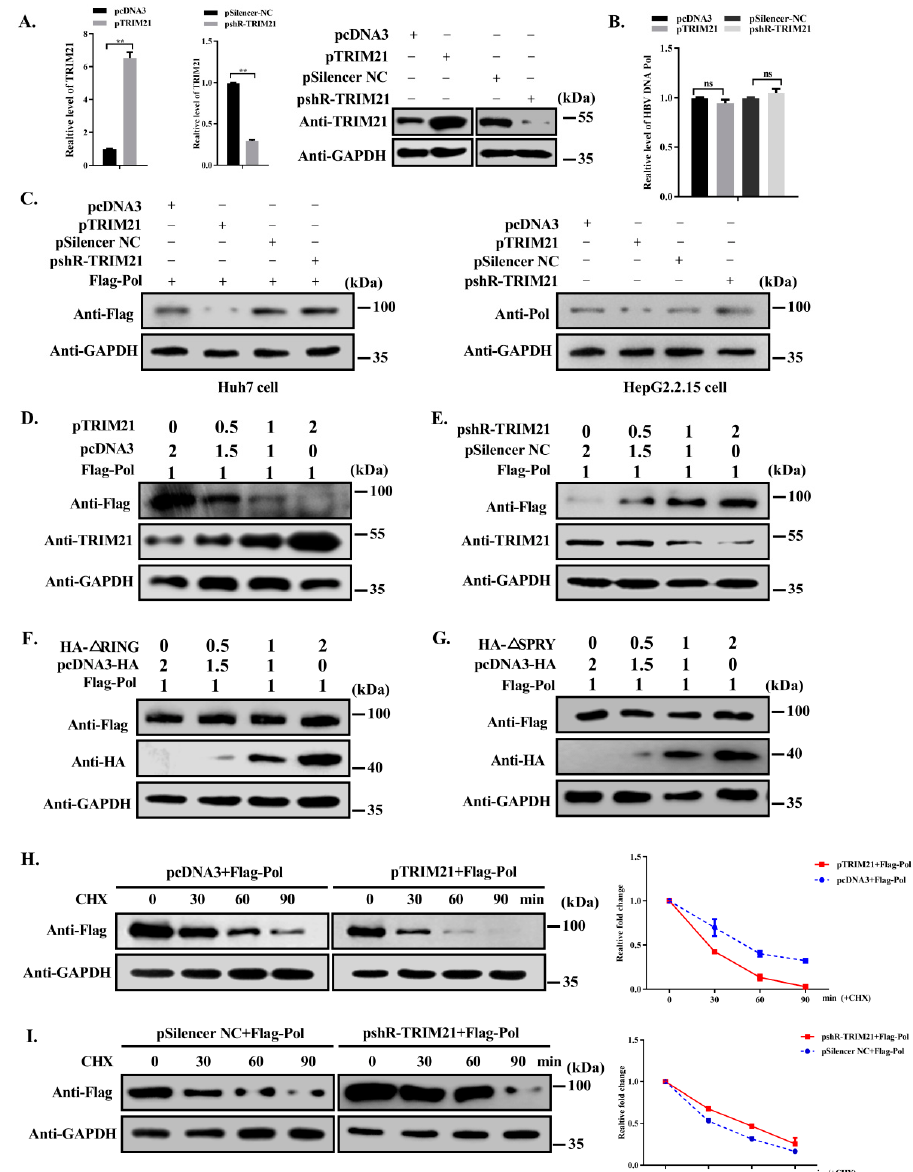
Figure 3. TRIM21 negatively regulates the stability of HBV DNA Pol. ( A ) Huh7 cells were transfected with TRIM21 overexpression or knockdown plasmids or control, and the level of TRIM21 mRNA or protein in the cells was detected by RT-qPCR and Western blot. ( B ) FLAG-HBV DNA Pol was cotransfected with TRIM21 overexpression or knockdown plasmid. The mRNA level of HBV DNA Pol was detected by RT-qPCR. ( C ) Huh7 cells were transfected as described in ( B ), and HepG2.2.15 cells were transfected with TRIM21 overexpression or knockdown plasmids. Western blot was used to detect the protein level of HBV DNA Pol with anti-FLAG antibody or anti-Pol antibody. ( D ) Huh7 cells were transfected with FLAG-HBV DNA Pol along with increasing amounts of TRIM21 expressing plasmid, and WWestern blot was used to detect the protein level of HBV DNA Pol. ( E ) As described in ( C ), except for using pshR-TRIM21 plasmid. ( F ) As described in ( C ), except for using TRIM21- ∆ RING plasmid. ( G ) As described in ( C ), except for using TRIM21- ∆ SPRY plasmid. ( H ) Huh7 cells were cotransfected with FLAG-HBV DNA Pol and pcDNA3 or TRIM21 plasmid. Thirty hours later, 100 µ g / ml cycloheximide was used to treat cells, and the protein level of HBV DNA Pol was detected by Western blot. ( I ) Huh7 cells were cotransfected with FLAG-HBV DNA Pol and pSilencer NC or pshR-TRIM21. The treatment was the same as in ( H ). Data are representative of three independent experiments with three replicates